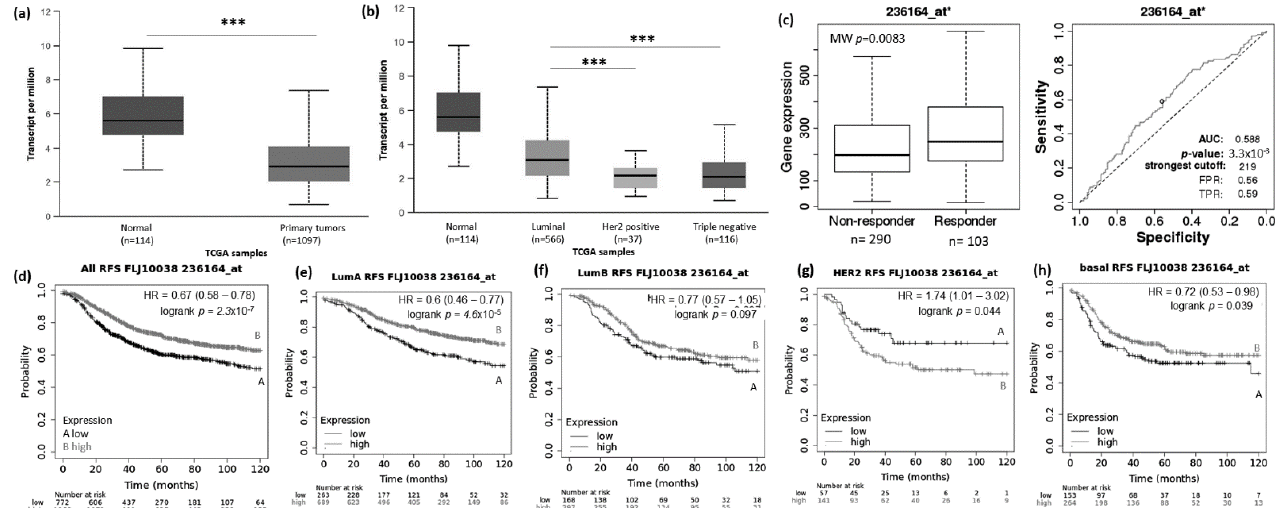
Figure 5. FLJ10038 lncRNA expression in breast cancer patients and association with taxane treatment response and prognosis. Expression of FLJ10038 lncRNA in breast cancer compared to normal breast tissue ( a ) and among different breast intrinsic subtypes using the UALCAN database containing TCGA data ( b ). ( c ) FLJ10038 lncRNA expression in groups of responders and non-responder breast cancer patients treated with taxane using the online platform ROCplot. ( d – h ) Kaplan–Meier curves for relapse-free survival of breast cancer patients for all subtypes ( d ) or each intrinsic subtype as luminal A ( e ), luminal B ( f ), HER2 ( g ), and basal ( h ) grouped as high or low expression of FLJ10038 according to the best cut-off value using the JetSet best probe set at the KMplot online tool. *** p < 0.001,; MW—Mann–Whitney test.